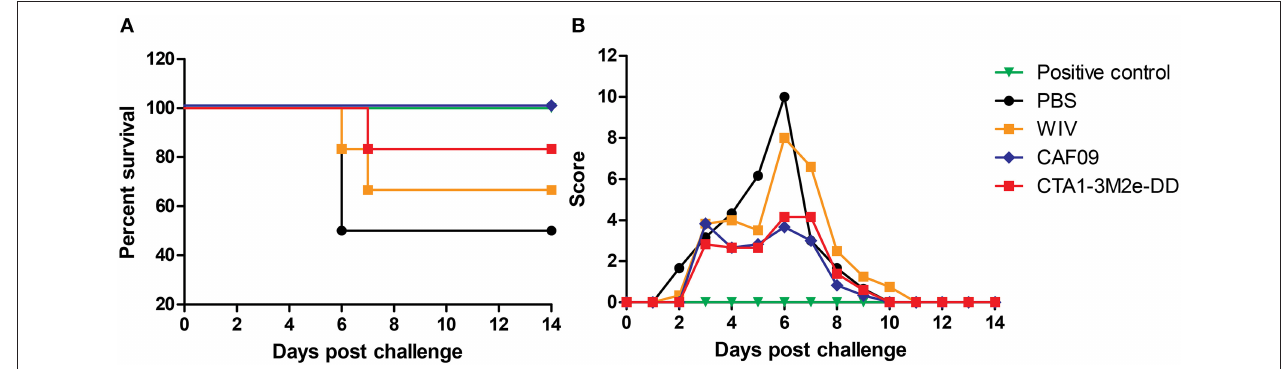
FIGURE 3 | Serum antibodies induced by mucosally adjuvanted WIV might induce cross-protection. Serum was collected from animals vaccinated thrice with PBS i.n., non-adjuvanted WIV i.n., WIV + CAF09 i.n., or WIV + CTA1-3M2e-DD i.n. and was administered passively in naïve mice ( n = 6) via the i.p. route. One day after passive immunization animals were challenged with heterosubtypic X-31 virus. Animals from the positive control group received PR8 immune sera and were challenged with homologous PR8 virus. The mice were followed for survival (A) and clinical symptoms (B) assessed using a score based on weight, appearance and